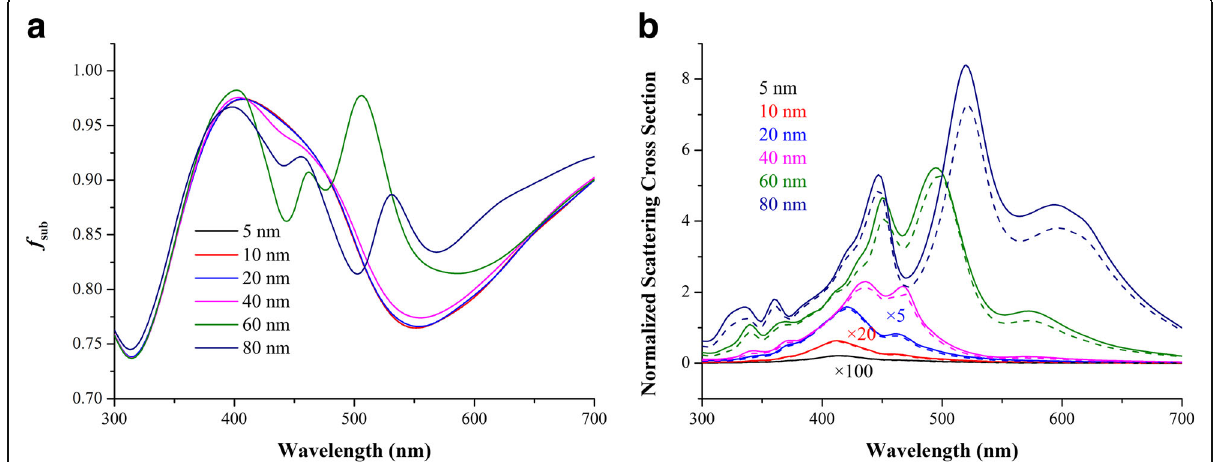
Fig. 3 a The fraction of light scattered into the active layer. b Total scattering cross section (solid), cross section for light scattered into the substrate (dashed line), all normalized to geometrical cross